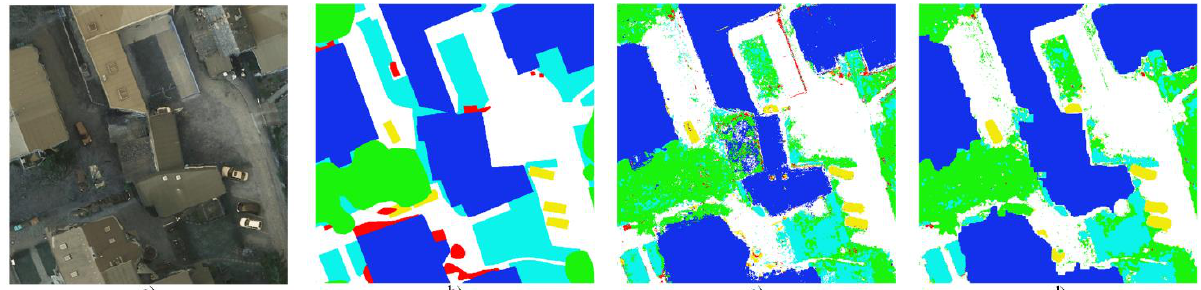
Figure 11. Building refinement on a part of patch No. 5-11 a) RGB view b) Ground truth c) Classified image with false negative rooftop as vegetation and small points d) Refining building detection on rooftop.